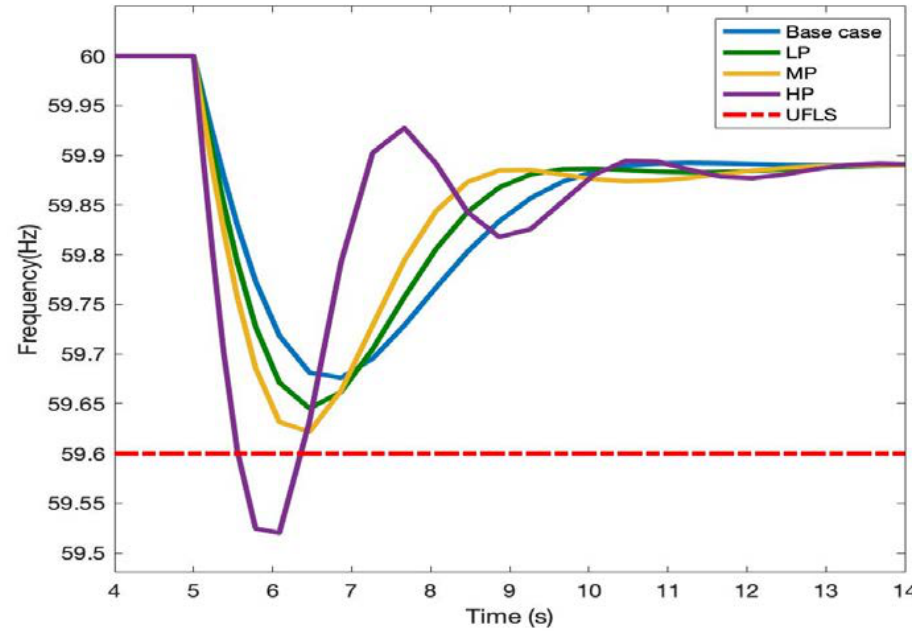
Figure 11. Frequency response under base load conditions in 2030.